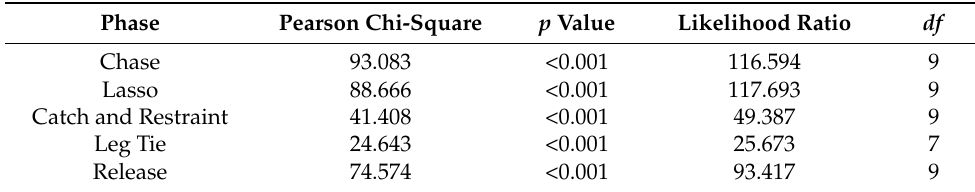
Table 4. Pearson chi-squared results for each of the phases of the calf-roping event at two rodeos ( n = 15 calves).